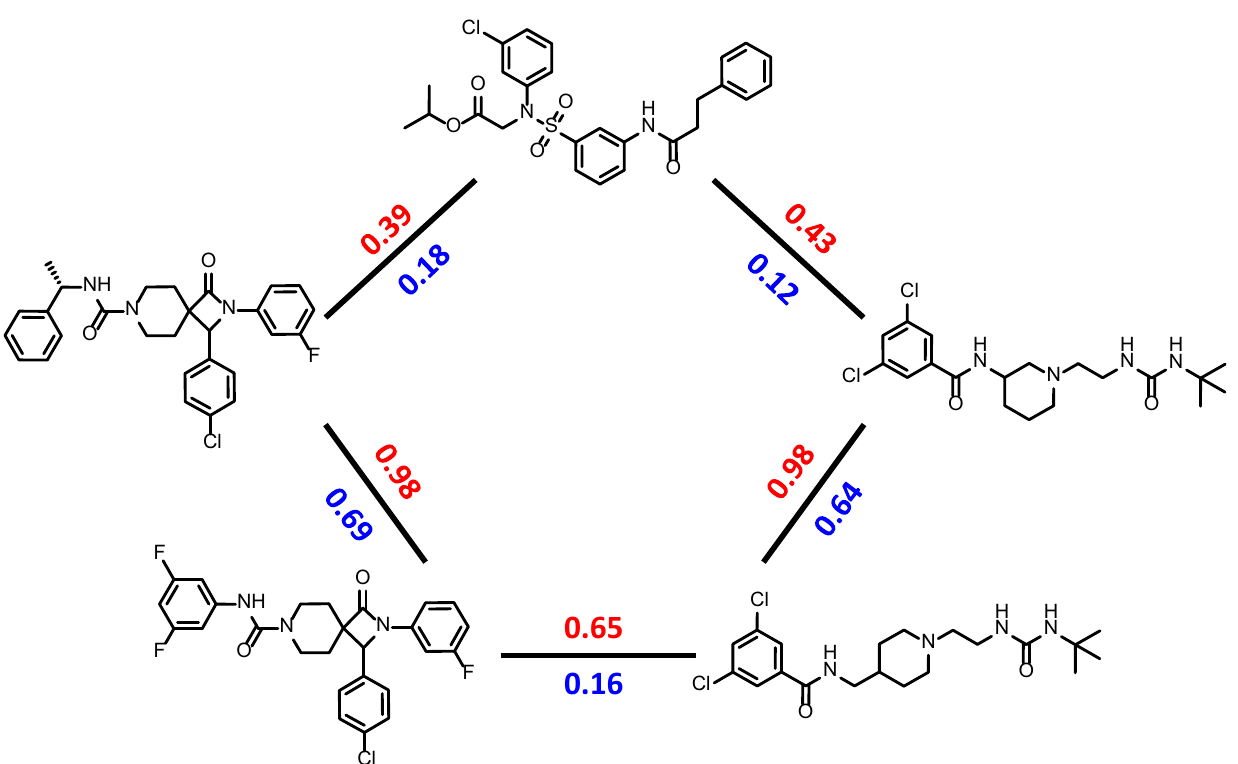
Figure 3. Pairs of active compounds with varying similarity values. Shown are five exemplary compounds active against the voltage- gated T-type calcium channel alpha-1H subunit (an “easy” activity class). Five pairwise similarity values calculated using MACCS (red) and ECFP4 (blue), respectively, are